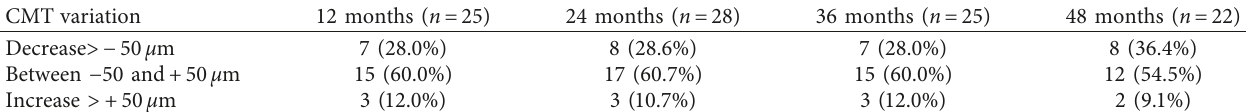
Table 3: Central macular thickness variation by groups until 48 months (primary outcome).